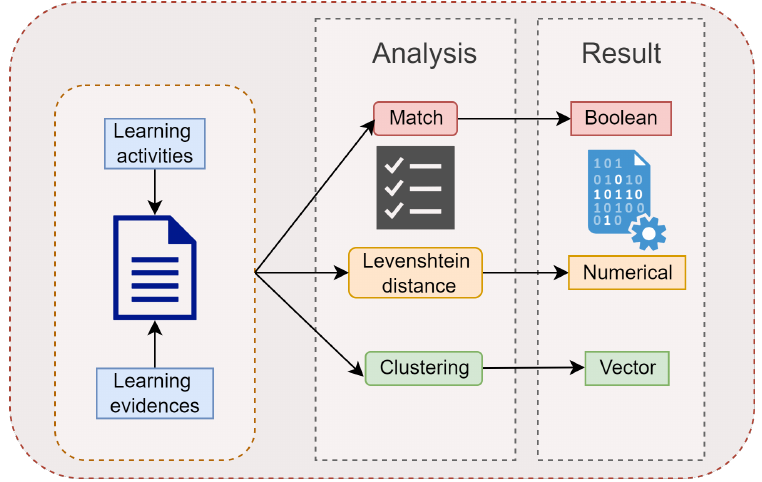
Figure 8. Scheme for the analysis of evidence and learning